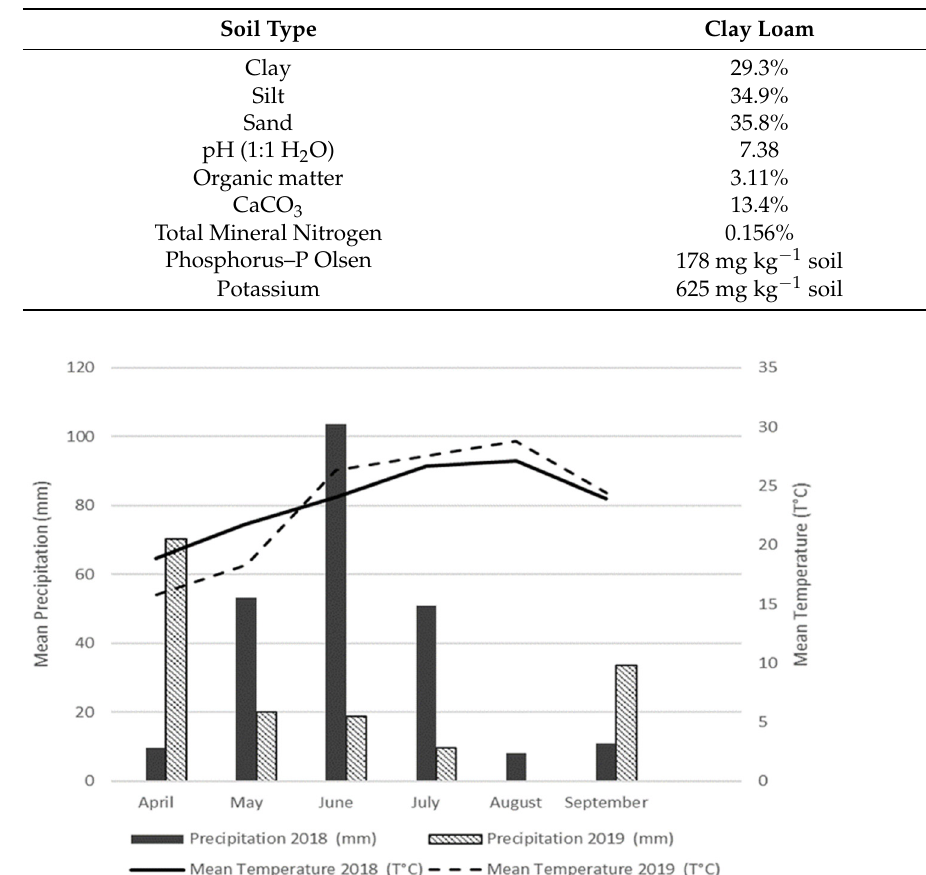
Figure 1. Meteorological data, mean air temperature (°C), and precipitation (mm) during the exper- imental periods (April–September) for the years 2018–2019. Table 1. Soil properties of the experimental